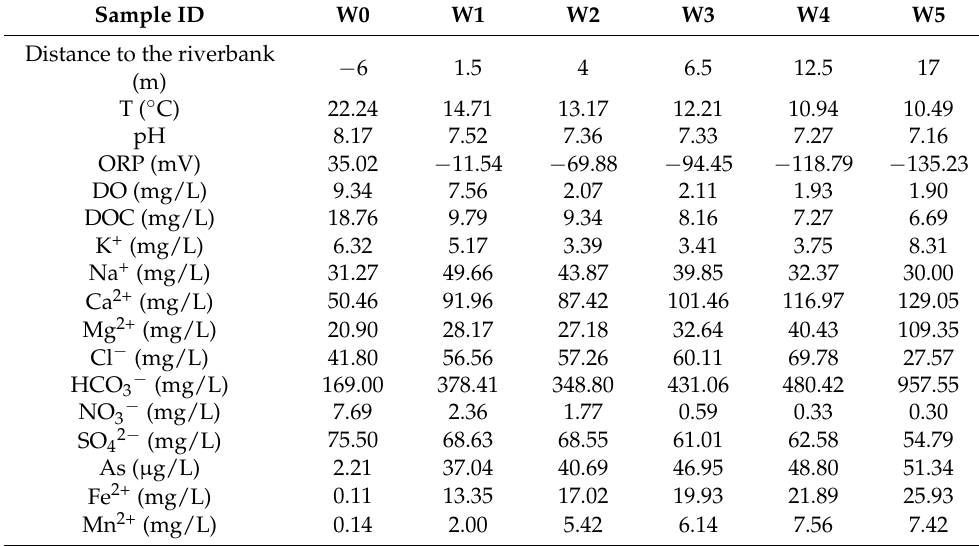
Table 1. Physico-chemical parameters in river water (W0) and groundwaters